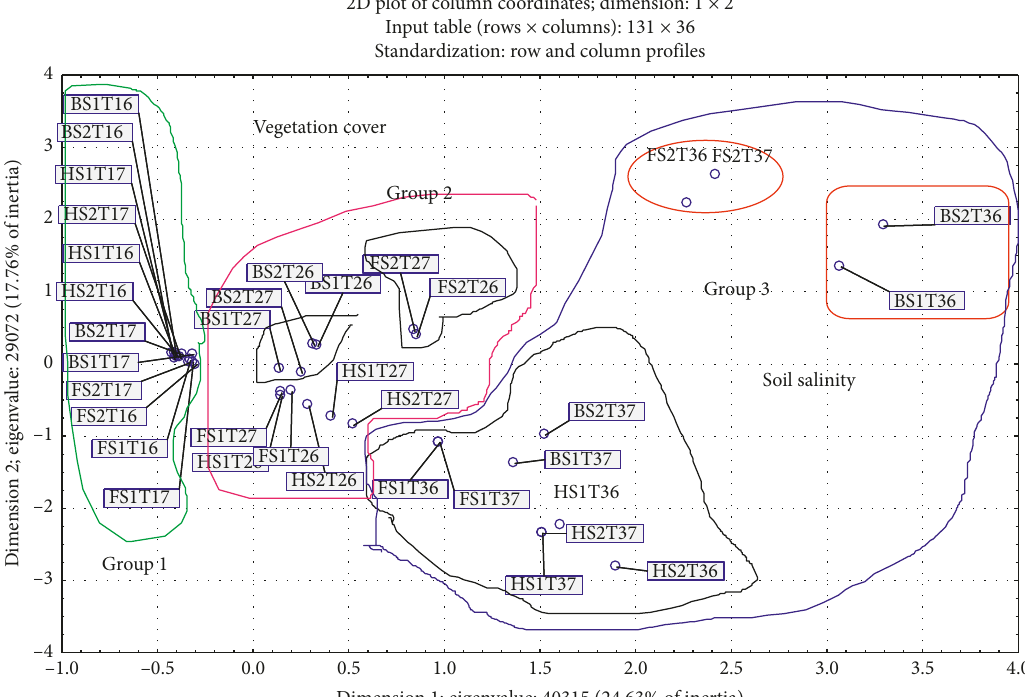
Figure 9: Factorial correspondence analysis (FCA) considering the abundance and distribution of the insect taxa at sites along the transect according to environmental